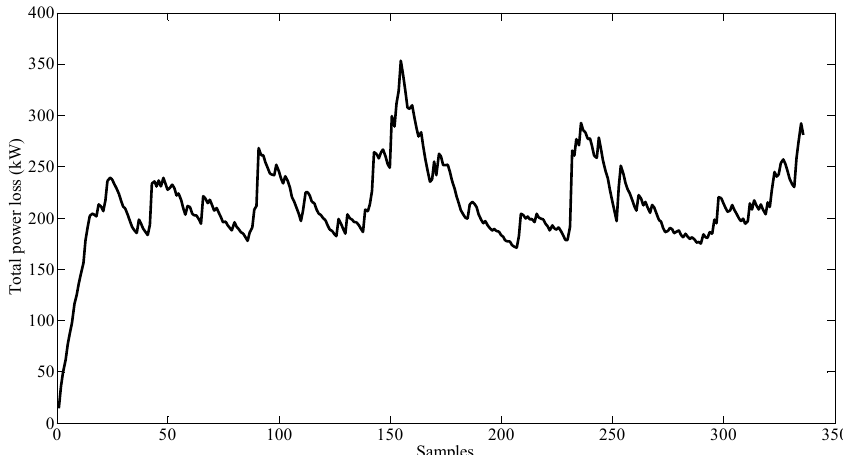
Figure 7. Optimal power loss when calculating PEV demand randomly.